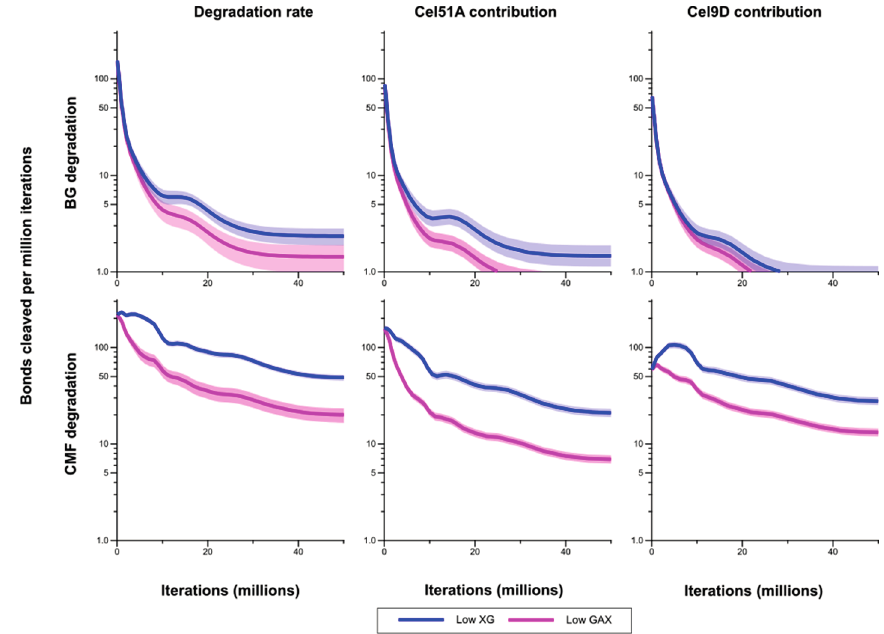
Figure 6. Bond cleavage rate in (1,3;1,4)- β -glucan (BG) and cellulose microfibrils (CMF) for Low XG and Low GAX cell walls, and the contributions of Cel51A and Cel9D to degradation of these polysaccharides. The shaded region represents a 95% Least Significance Interval so that the two curves are significantly different from each other at the 5% level where they do not overlap. The solid line in the middle indicates the